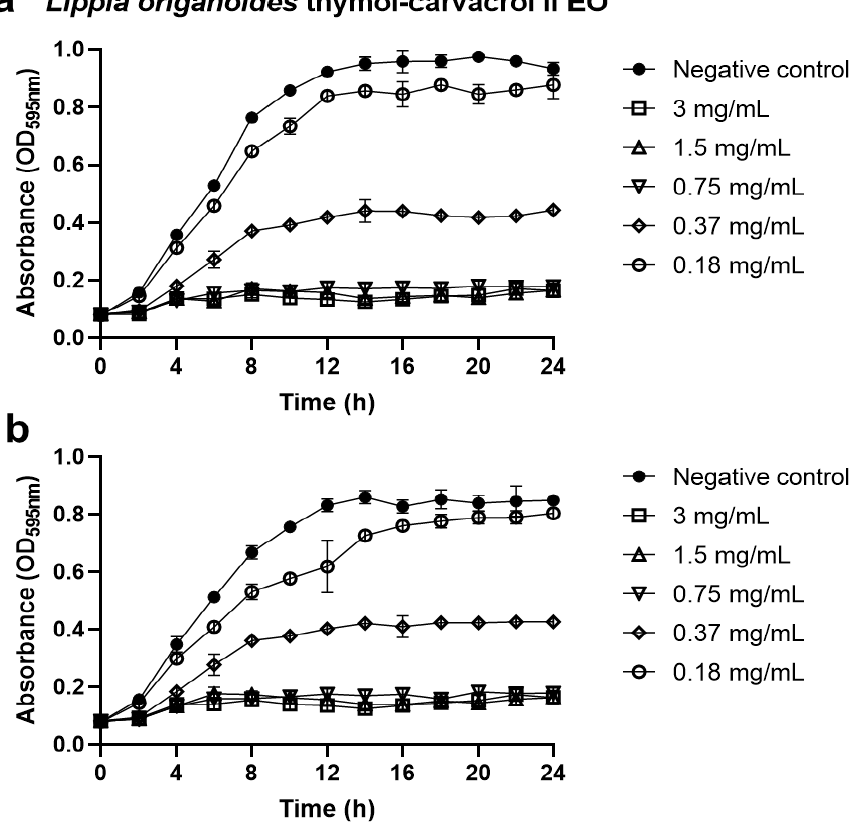
Figure 1. Antibacterial activity of the essential oil “thymol-carvacrol-chemotype (II)” from Lippia origanoides against the growth rate of E. coli O157:H7 ( a ) and S. epidermidis ATCC 12228 ( b ). Data are presented as the mean ± SD of absorbance measured at 595 nm.